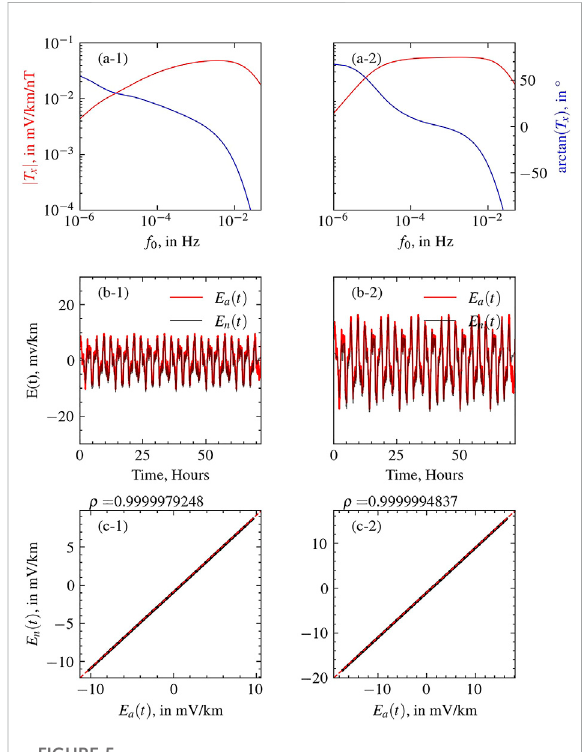
FIGURE 5 Model validation using following layered Ocean-Earth conductivitymodels:1)Uniformand2)Atlanticmodeldescribedin Table 2. From top to bottom rows present: (A) Amplitude and phase spectrum of the transfer function, T x . (B) Time series of analytically (red) and numerically (black) estimated induced electric fi eld. (C) Correlation analysis between analytically ( E a ( t )) and numerically ( E n ( t )) calculated induced electric fi eld. The correlation coef fi cient ( ρ ) between E a ( t ) and E n ( t ) is provided in the top left corner of the panel. Example Python notebook for this experiment is uploaded in Zenodo